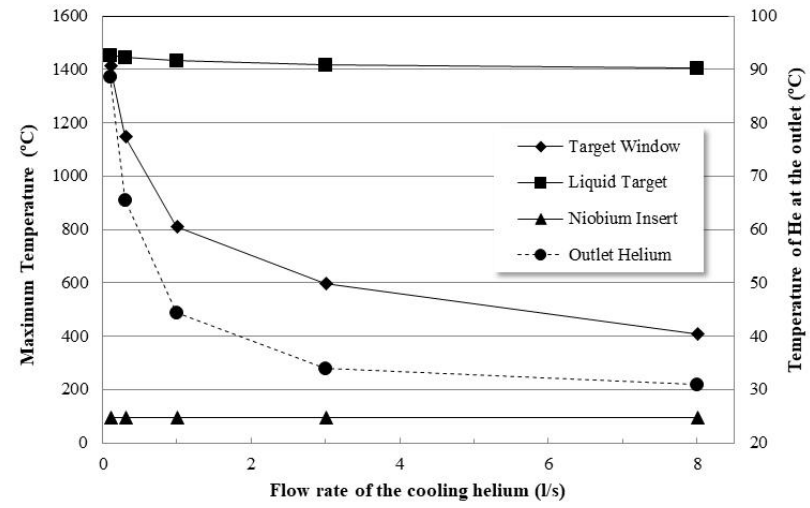
Figure 19. Maximum temperatures of the target window, liquid target, niobium insert (full lines) and temperature of the cooling helium at outlet (dashed line) as a function of the flow rate of the cooling helium.